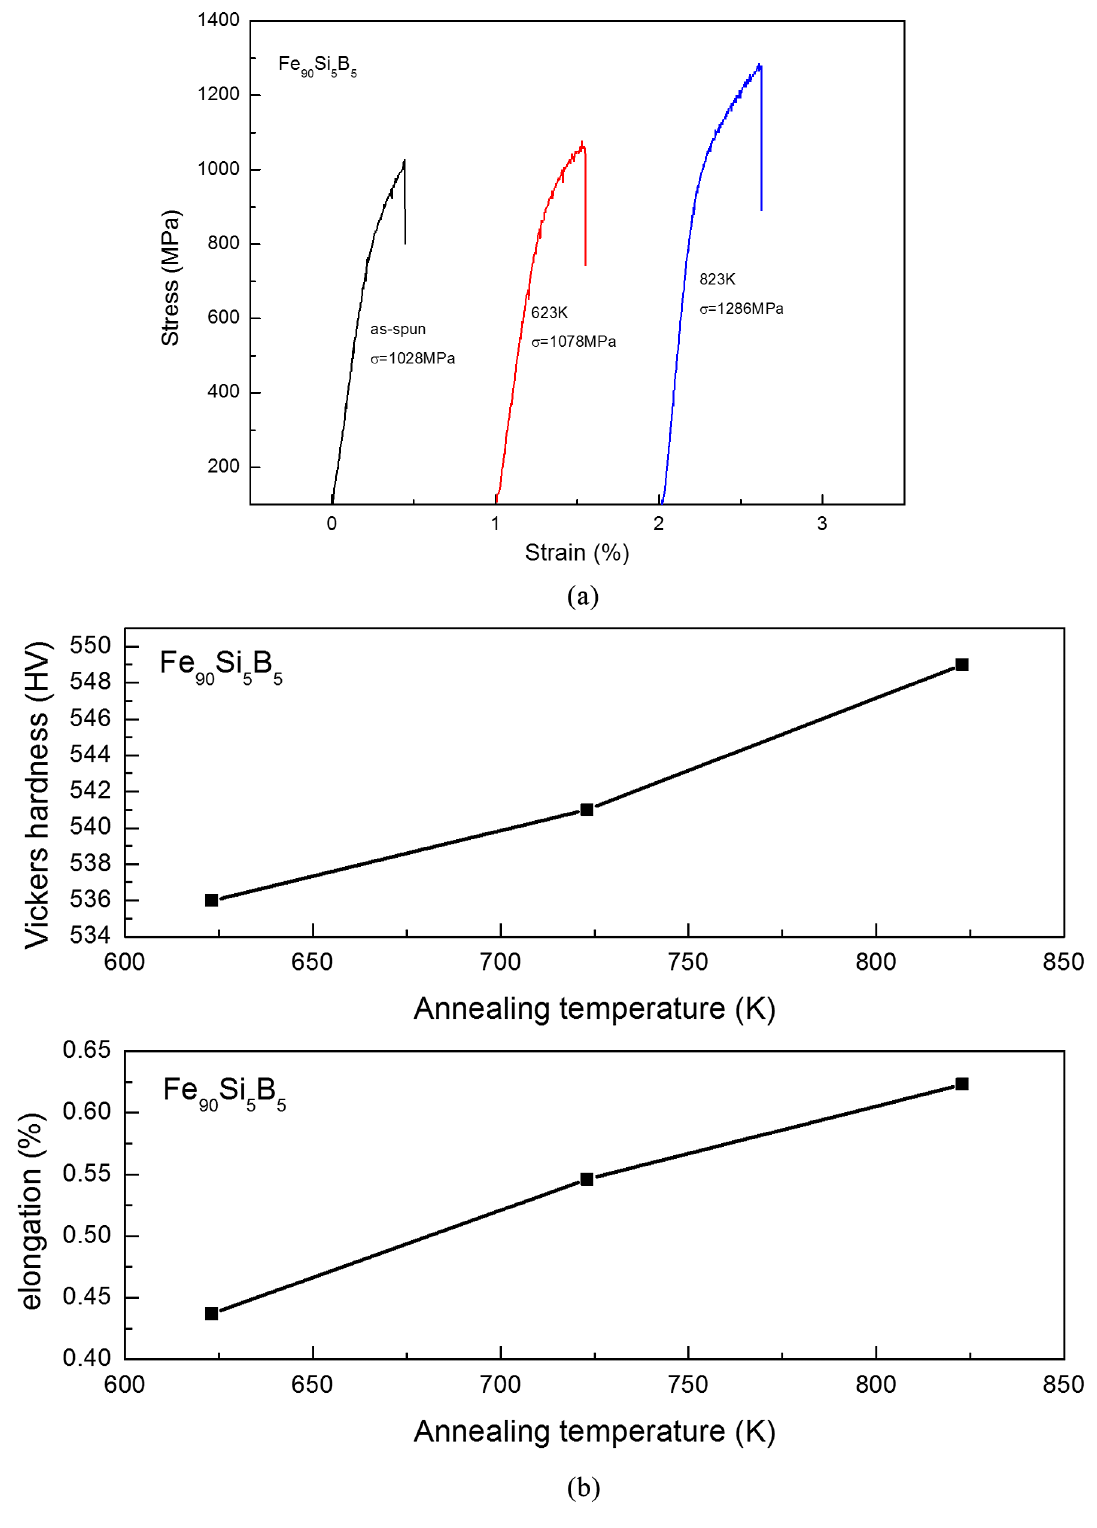
Figure 7. (a) Tensile curve of the Fe respectively; (b) Plots of Vickers hardness – annealing temperature vs. elongation - annealing temperature of Fe as-spun state, after annealing at 623K and 823K,